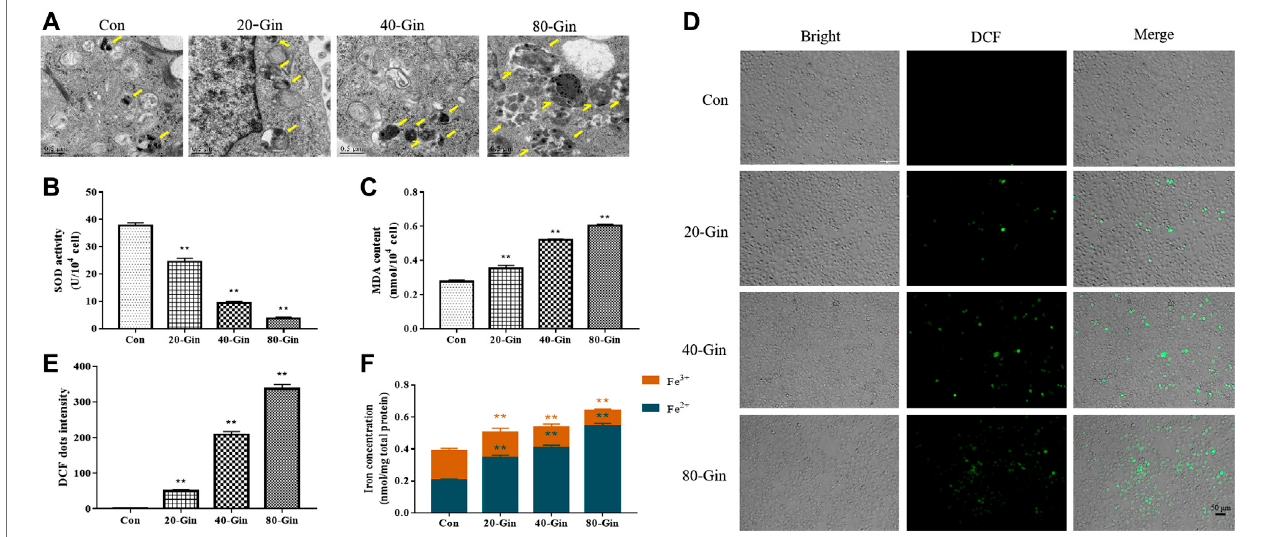
FIGURE 4 | 6-Gingerol exacerbates autophagy and enhances the accumulation of ROS and iron in A549 cells. (A) The autophagy electron microscope image of A549 cells, and yellow arrows marked the autophagy structure; (B) The activity of SOD in A549 cells; (C) The content of MDA in A549 cells; (D) The ROS fl uorescence (DCF) ofA549cells; (E) The histogram of ROScontentofA549 cells; (F) The iron concentrationin A549cells. Con: control, 20-Gin:20 μ M 6-Gingerol,40-Gin:40 μ M 6- Gingerol, 80-Gin: 80 μ M 6-Gingerol. Compared with the control group, * p < 0.05, ** p < 0.01. Data are expressed as mean ± SD ( n (cid:2) 3).